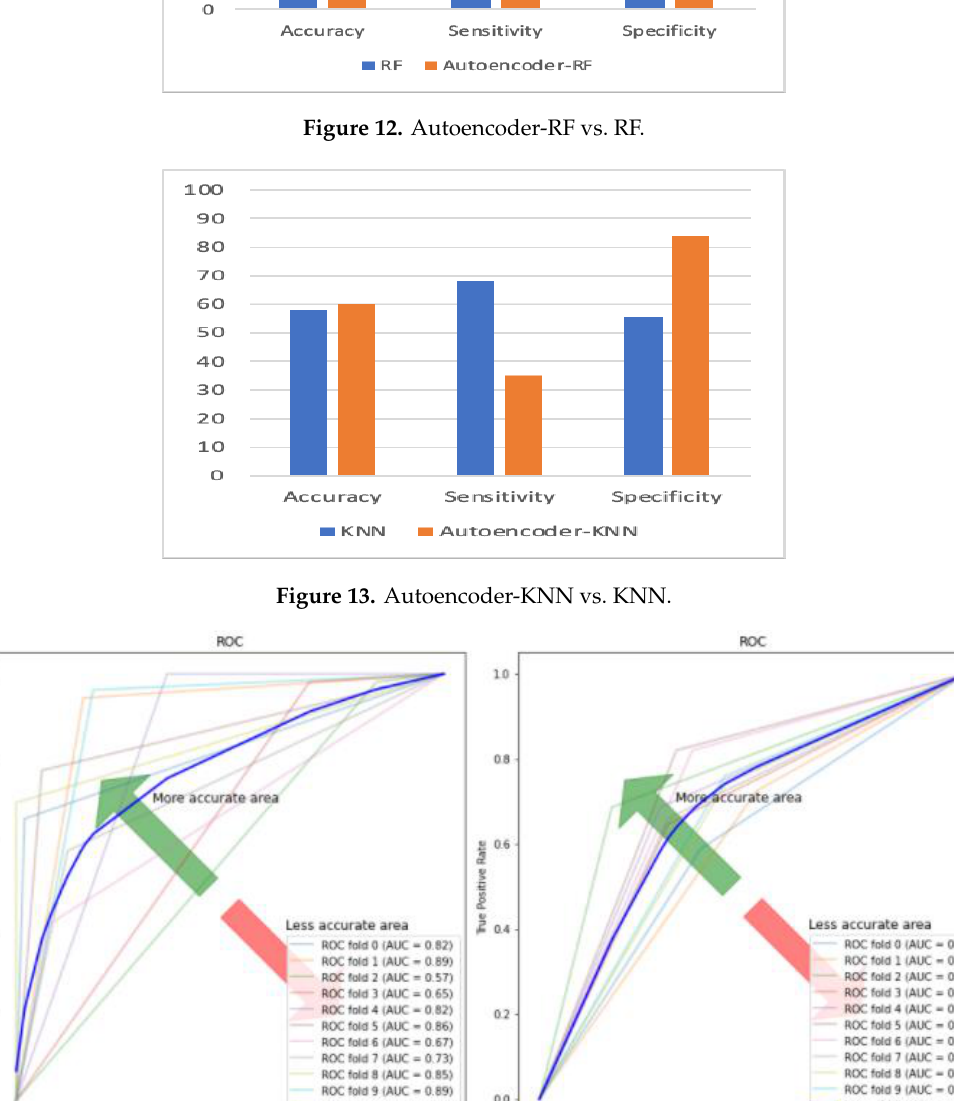
Figure 15. ROC curve and AUC values for autoencoder–SVM ( Left ) and SVM ( Right ).